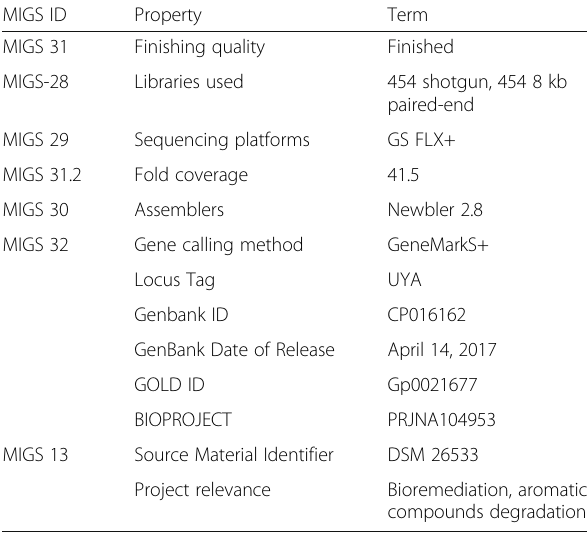
Table 2 Genome sequencing project information for